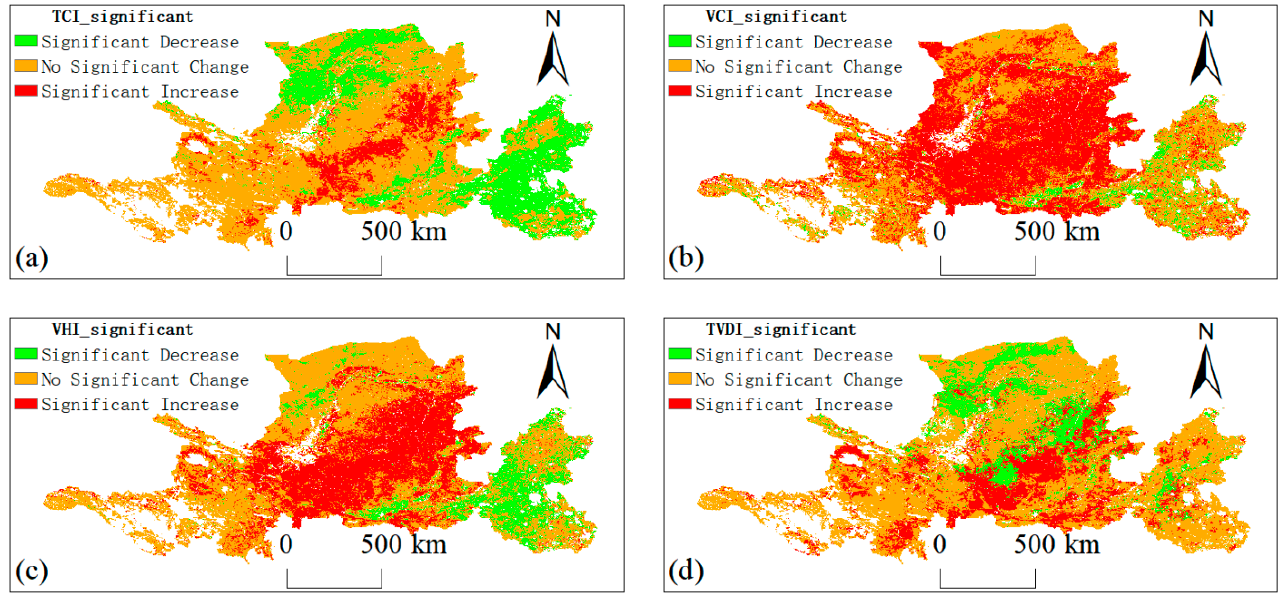
Figure 7. Significance of drought indices change trends during the period 2003–2019. ( a ) TCI; ( b ) VCI; ( c ) VHI; ( d ) TVDI.